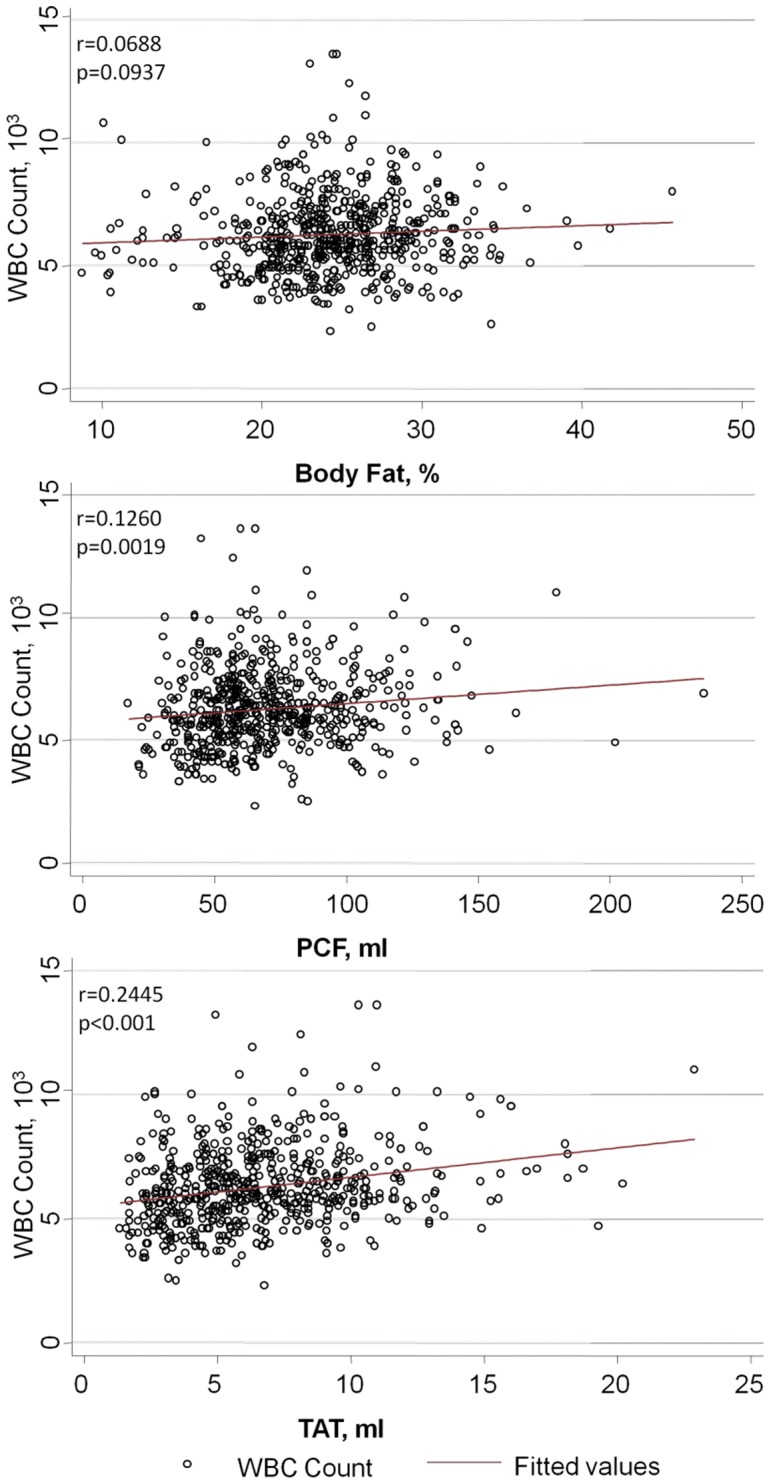
Correlation between measures of various adiposity (body fat composition and both visceral adipose tissue volume) and circulating WBC counts.Though body fat composition and visceral adipose tissue volumes had positive linear correlations with WBC numbers, only the correlation with TAT remained significant after multivariable adjustment. Clinical variables in the model included age, gender, systolic blood pressure, fasting glucose, cholesterol, high-density lipoprotein, estimated glomerular filtration rate, exercise, smoking and alcohol consumption. BMI, body-mass index; BSA; body surface area; WBC, white blood cell; PCF, pericardial adipose tissue; TAT, thoracic peri-aortic adipose tissue.